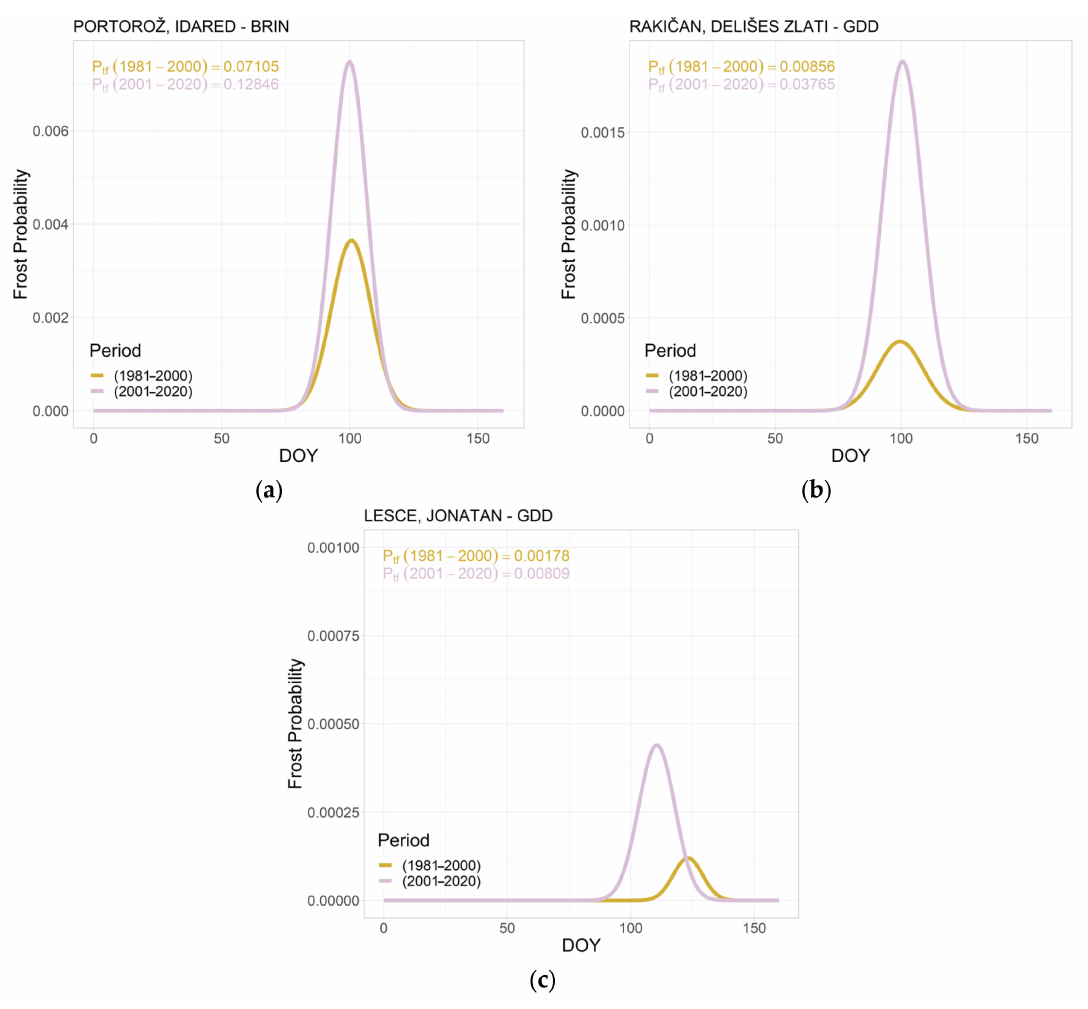
Figure 6. Three examples of modeled results of the probability of spring frost for the analyzed apple-growing regions of Slovenia by their climate type: ( a ) sub-Mediterranean climate and the Idared variety (Portorož); ( b ) subcontinental climate and the Golden Delicious variety (Rakiˇcan); and ( c ) moderate climate of the hilly region and the Jonathan variety (Lesce).